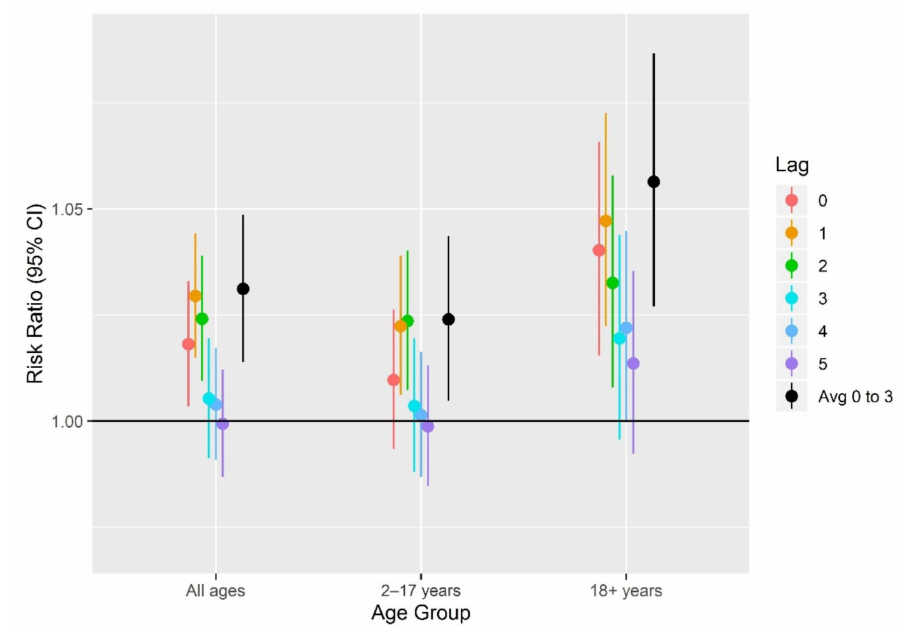
Figure 2. Risk ratios of respiratory ED visits in Mexico City corresponding to one interquartile increase in O 3 concentration, by lag structure and age group. Significant, positive associations with O 3 were consistently observed for population-level respiratory risks among children and adults in Mexico City. Multi-day lag structures were better able to account for health risks as compared to individual